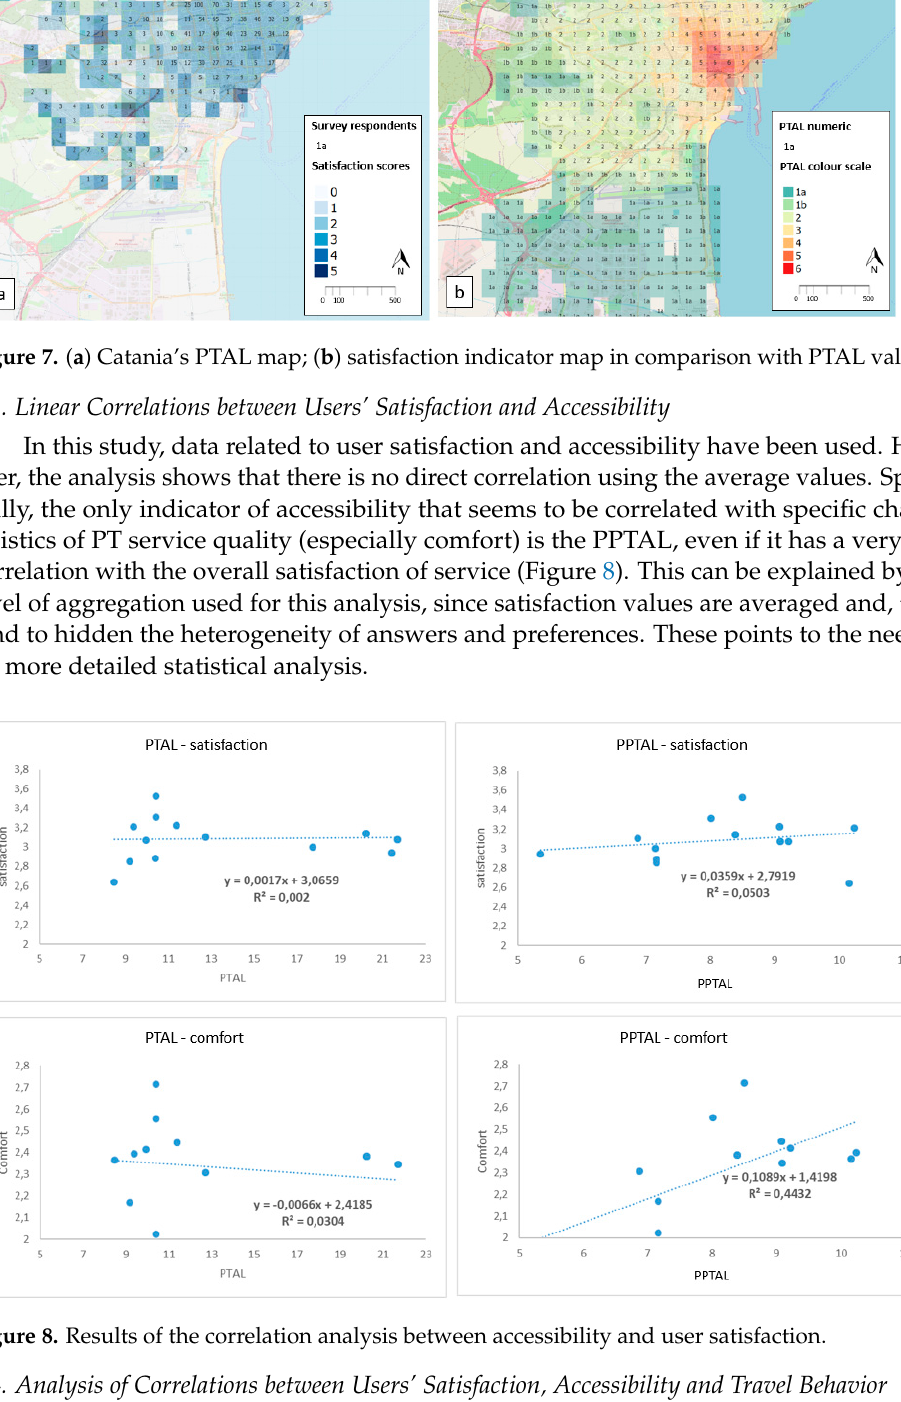
Figure 7. ( a ) Catania’s PTAL map; ( b ) satisfaction indicator map in comparison with PTAL values